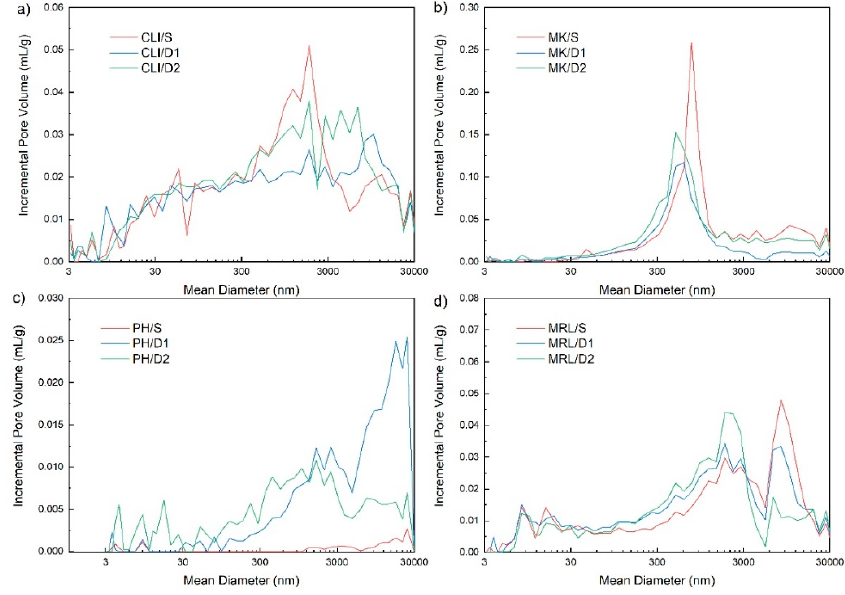
Figure 4. Pore distribution determined by Hg porosimetry of clinoptilolite ( a ), metakaolin ( b ), phonolite ( c ) and marlstone ( d ) .